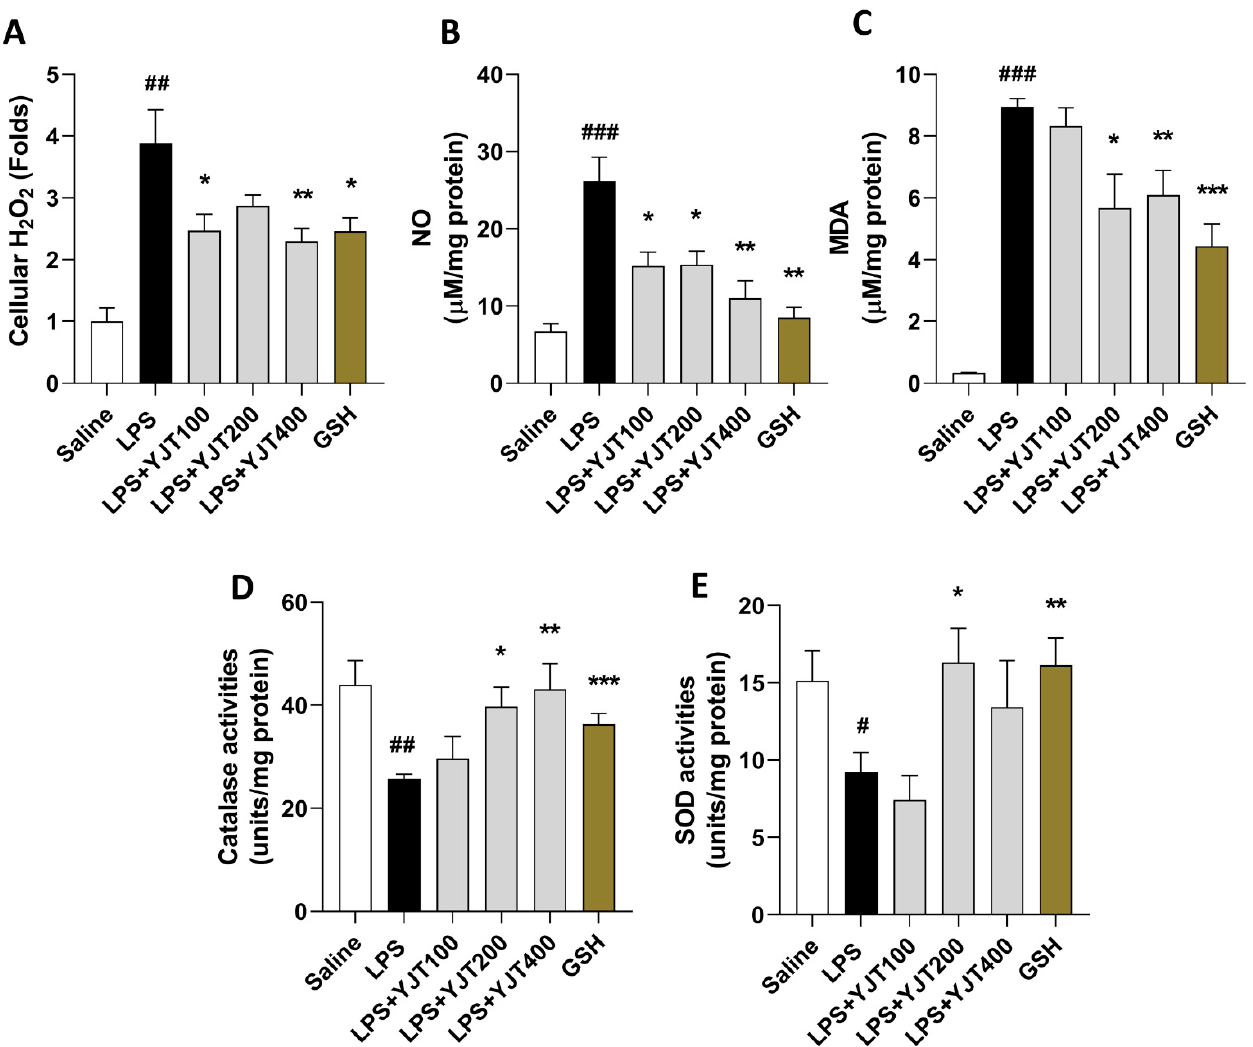
Figure 1. YJT ameliorated LPS–induced hippocampus oxidation in the protein levels. Mice were sacrificed and brain tissues were removed after the final LPS injection. The hippocampus was isolated from brain tissue, and protein lysate was prepared for further analysis ( n = 6–9 in each group). Hippocampus cellular levels of ( A ) H 2 O 2 , ( B ) NO, ( C ) MDA, ( D ) catalase activities, and ( E ), SOD activities were measured. The data were expressed as mean ± SEM. # p < 0.05, ## p < 0.01 and ### p < 0.001 for Con vs. LPS, * p < 0.05, ** p < 0.01, and *** p < 0.001 for LPS vs. drug–administrated groups.